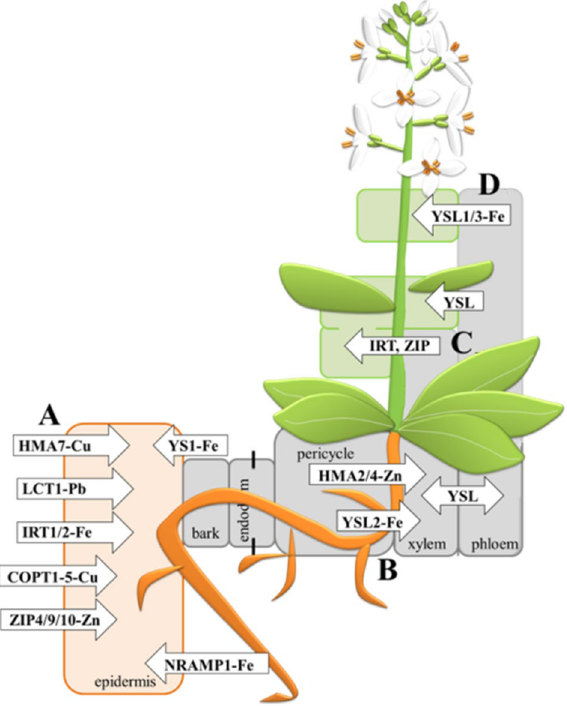
Figure 3. Generic diagram of the localisation of postmembrane trace metal transporters in higher plants. Part ( A ) uptake of metals to the roots, ( B ) transport to xylem/phloem, ( C ) transport to the leaves, ( D ) transport to the seeds (metals transporters: HMA2/4 for Zn; ITR1/2 for Fe; HMA5 for Cu, ZIP family, LCT1 channels, Nramo family for Fe, Ca and Zn; COPT1 for Cu, YSL family for Fe).